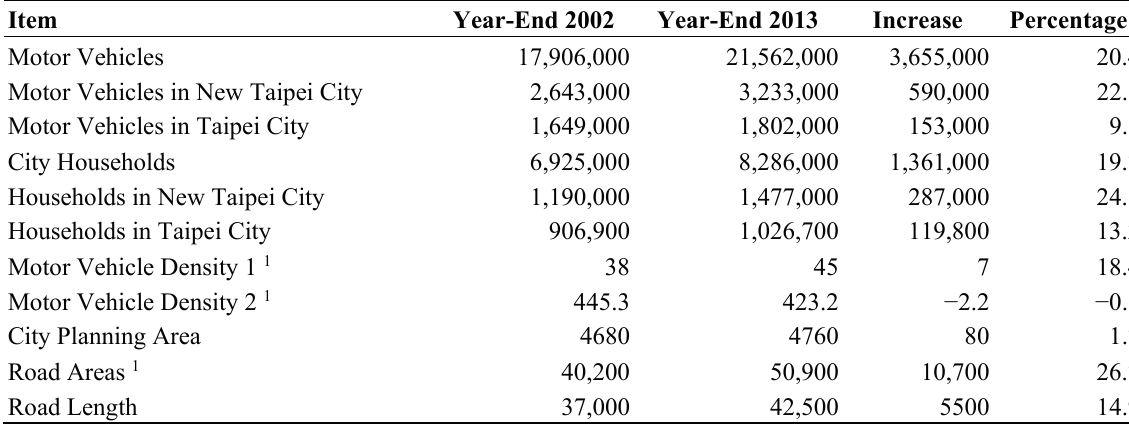
Source: This figure was produced by this study and arranged from [1,17]. Table 3. Density of motor vehicles, household, and road construction development in Taiwan’s cities, 2002 to